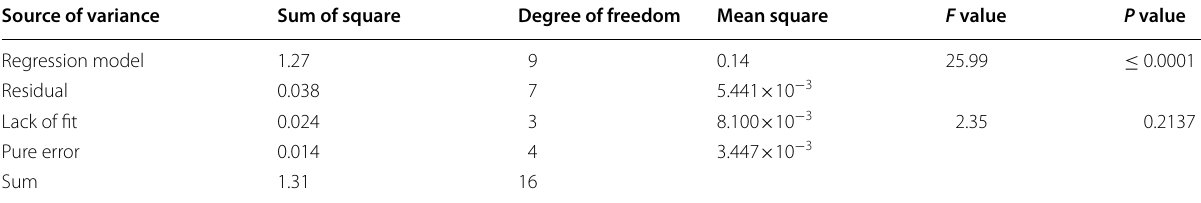
Table 9 Significance verification of surface roughness regression model Source of variance Sum of